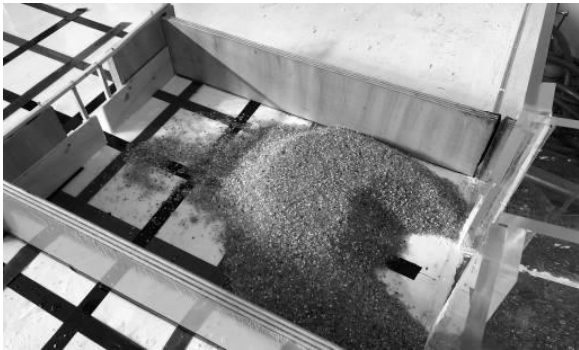
Figure 11. Control (capture) status by the weiring effect.